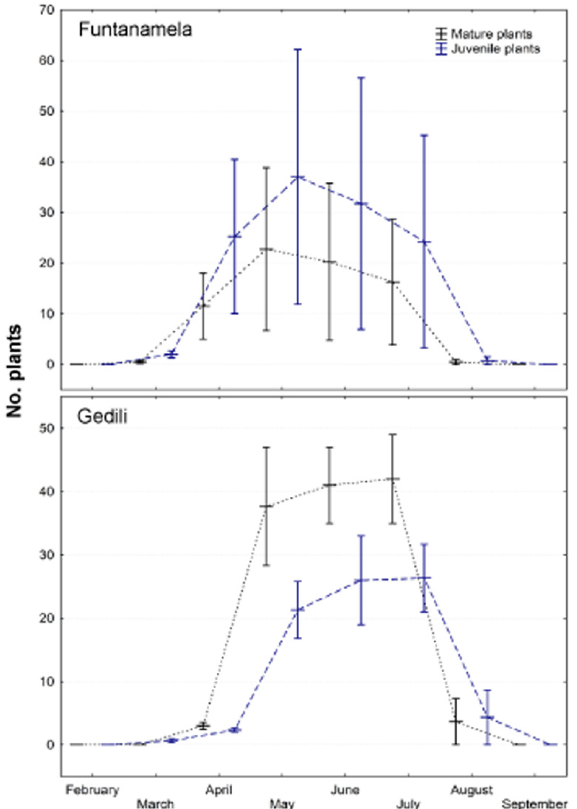
Figure 2. Mean values ( ± SE) of juvenile and mature plants per month in Funtanamela (Laconi) and Gedili (Jerzu) during the 8-year period of monitoring.